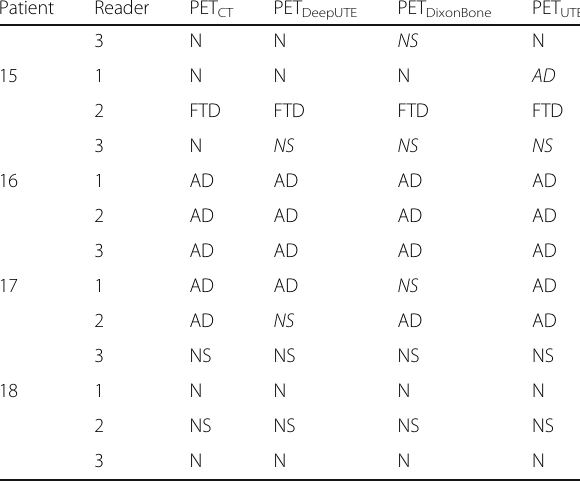
Table 4 Assigned diagnostic categorization for each patient made by three nuclear medicine physicians from PET images with three MRAC methods (PET DeepUTE , PET DixonBone , PET UTE ) and PET CT . Cerebellum was used as reference region. Intra-reader discrepancies with PET CT as reference are italicized (Continued) Patient Reader PET